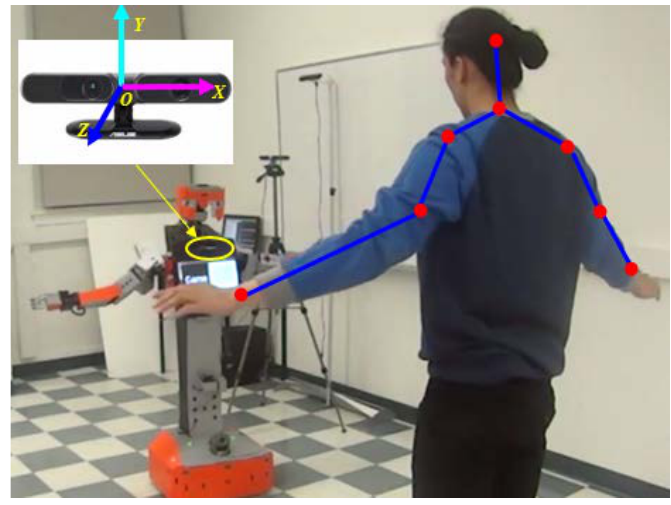
Figure 9. The Tangy robot using the ASUS Xtion 3D sensor to learn human demonstrator motions.